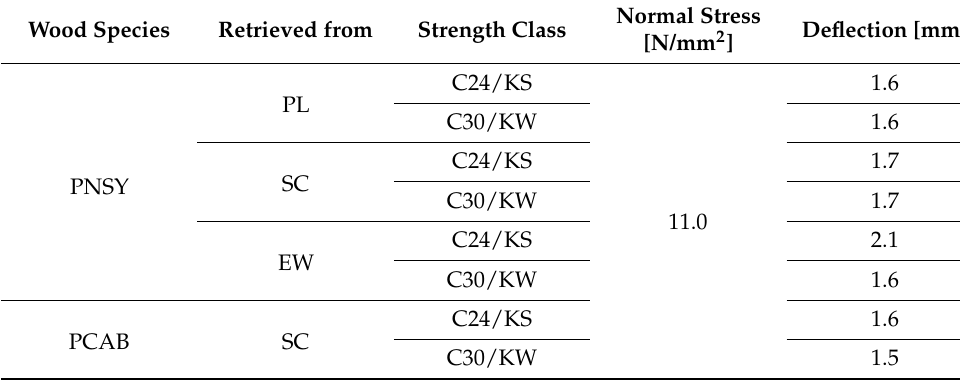
Table 10. Normal stresses and deflection (displacement) of F version short frames made of glued material with a finger-jointed lamella length of 400 mm.